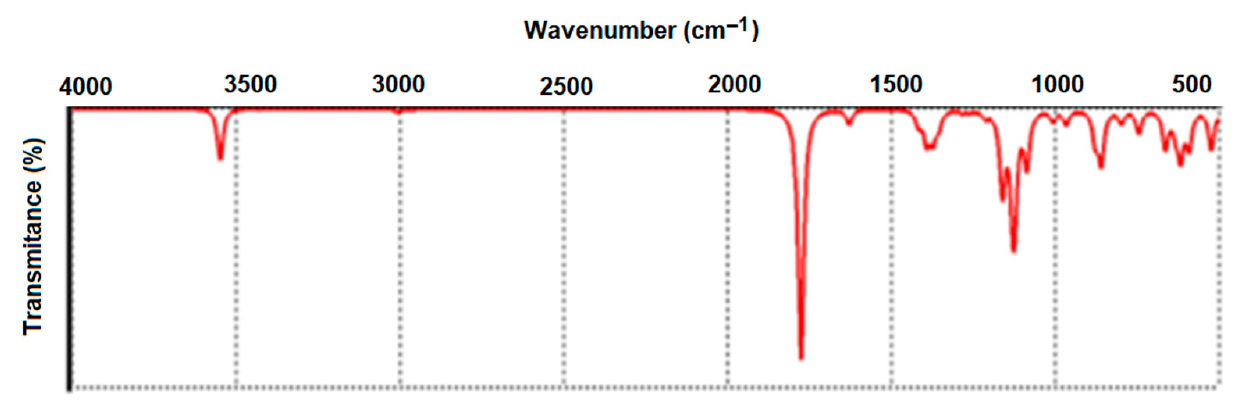
Figure 8. Simulated vibrational spectrum of aspartic acid (Density Functional).